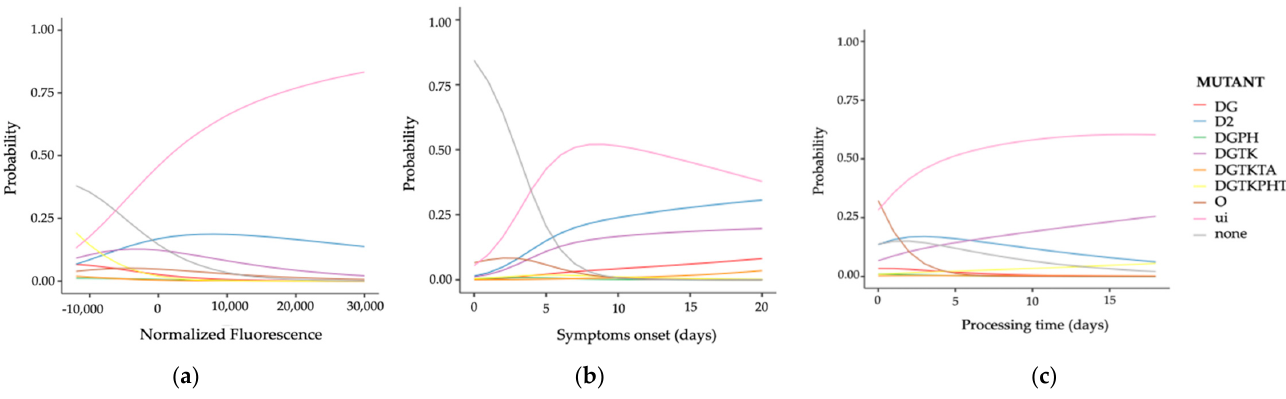
was assumed that any curve depicted below it meant a lower probability of detection.